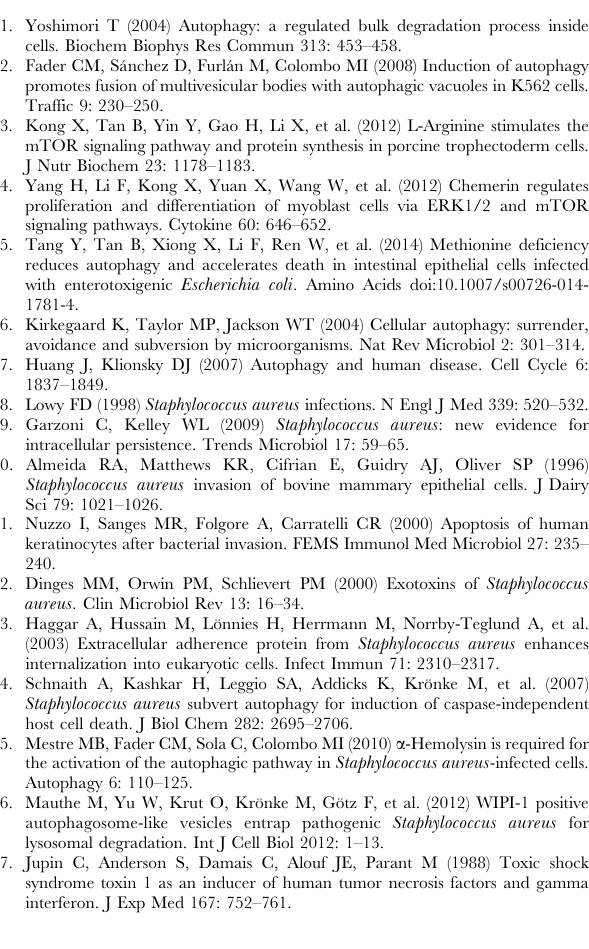
Figure S1 rTSST-1 does not enhance autophagosome and lysosome fusion. (TIF) Figure S2 rTSST-1 suppresses GFP-LC3 puncta forma- tion in the nutrient-starved HeLa 229 cells in a dose- dependent manner. (TIF) Figure S3 Construction of TSST-1 deficient mutant. (TIF) Figure S4 Growth of D tst is comparable with that of the WT. (TIF) Figure S5 Effect of TSST-1 on adhesion assay. (TIF) Figure S6 Effect of TSST-1 on invasion assay at MOI 10 and 100. (TIF)